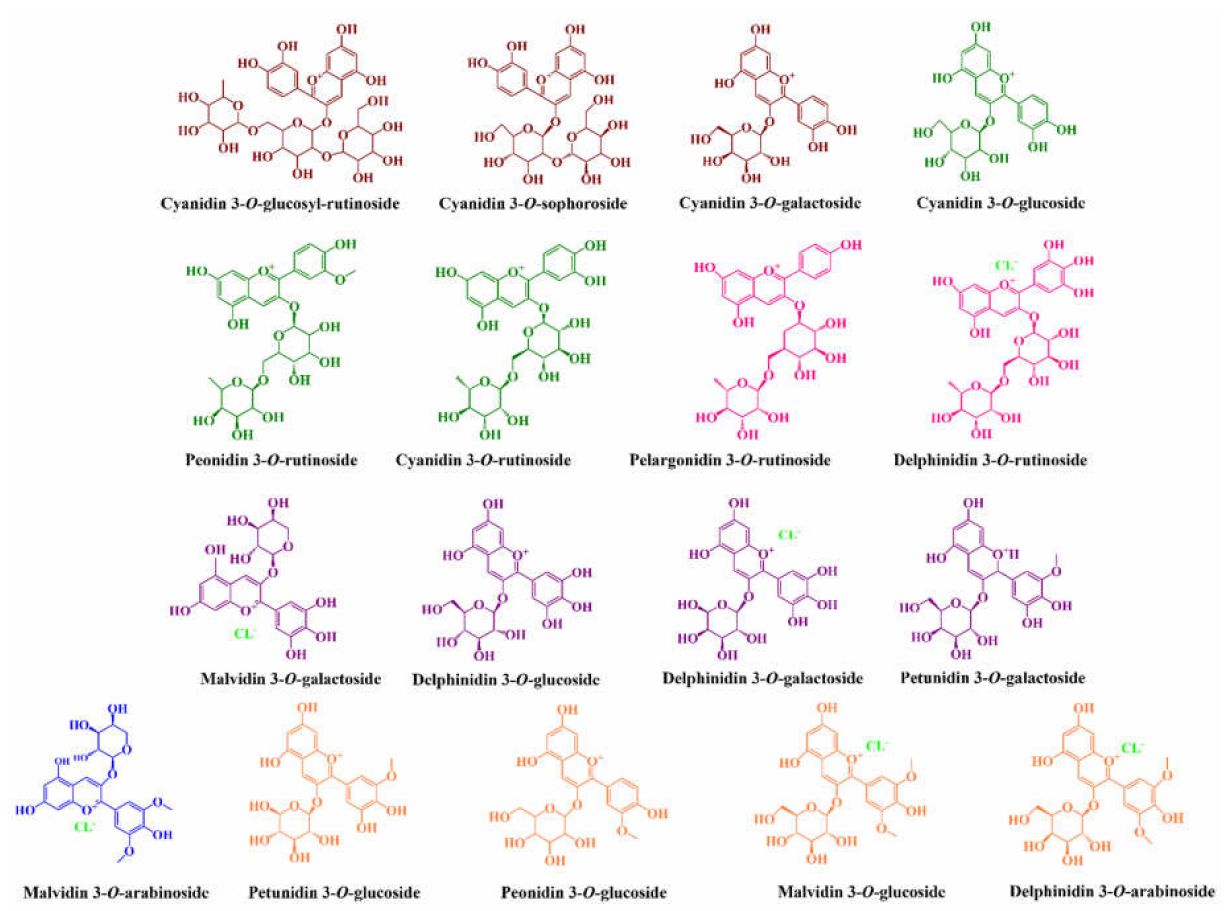
Figure 1. Main anthocyanins reported in tart cherries (brown color), sweet cherries (pink color), and both cherries (green color), highbush blueberries (purple color), rabbiteye blueberries (blue color), and both blueberries (orange color). (Figure created with ChemDraw Professional 16.0 (CambridgeSoft, Perkin Elmer Inc., Waltham, MA,